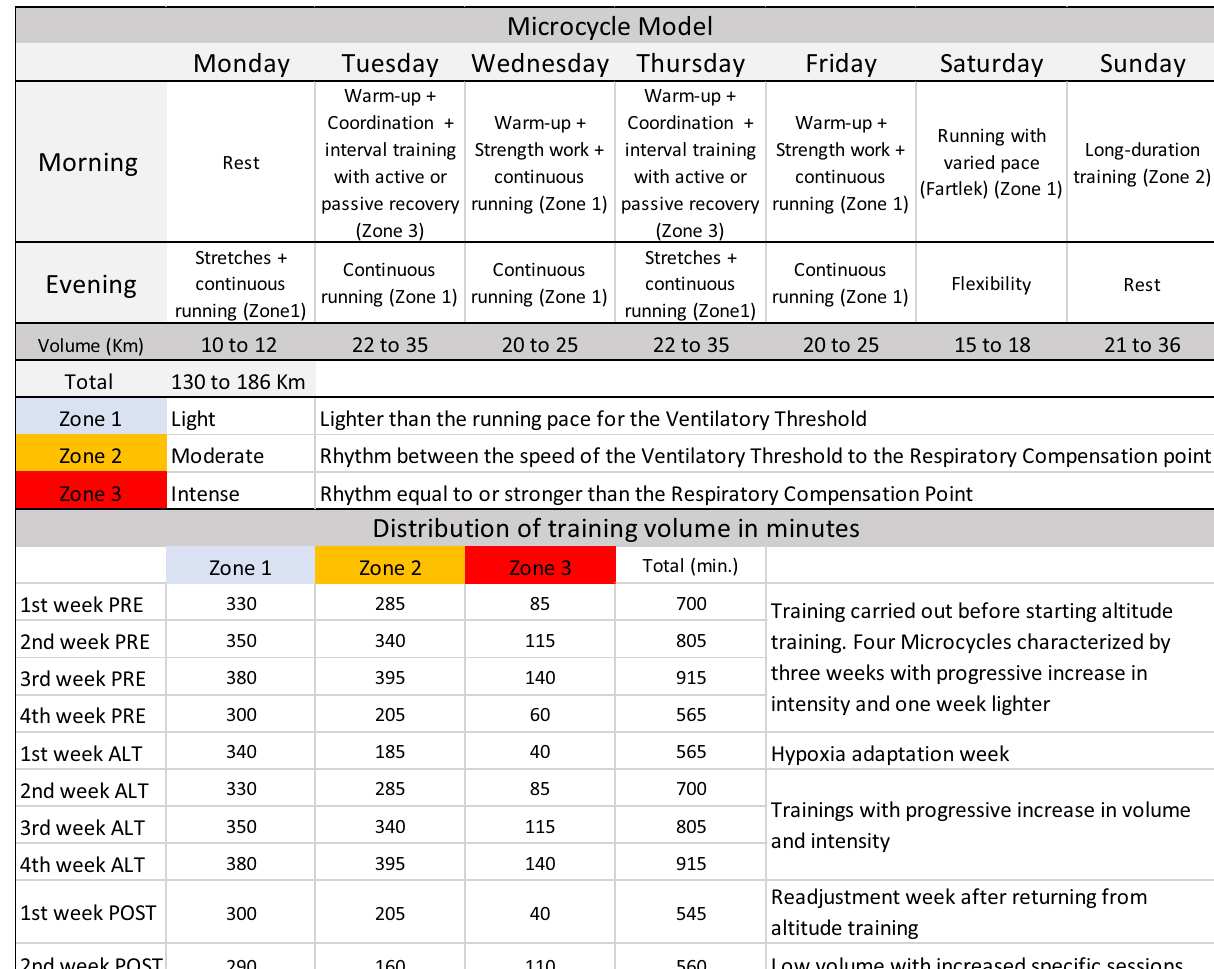
Figure 2. Training model (microcycle) used during altitude training, with details on intensity and quantity in minutes, regarding the training performed 4 weeks before, during, and 2 weeks after altitude